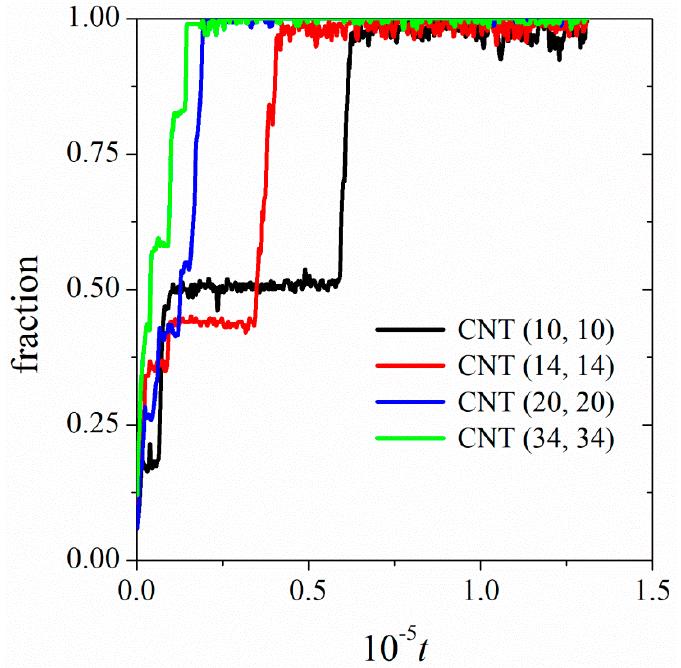
Figure 3. Time dependence of the fraction of DPPC molecules adsorbed on the surface of CNTs. All systems contain 250 lipid molecules, and the type of CNT is shown in the figure legend.